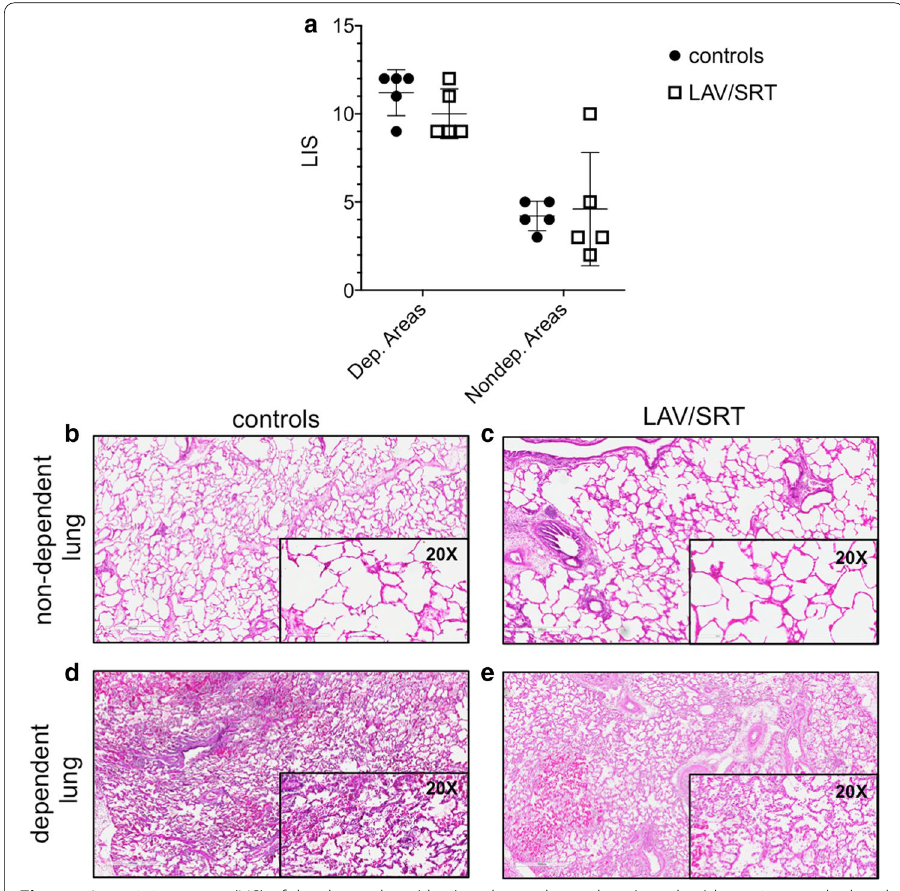
vascular congestion, edema, and fibrin deposition. b – e Representative images ( and eosin histologic sections from b , c non-dependent and d , e dependent lung tissue